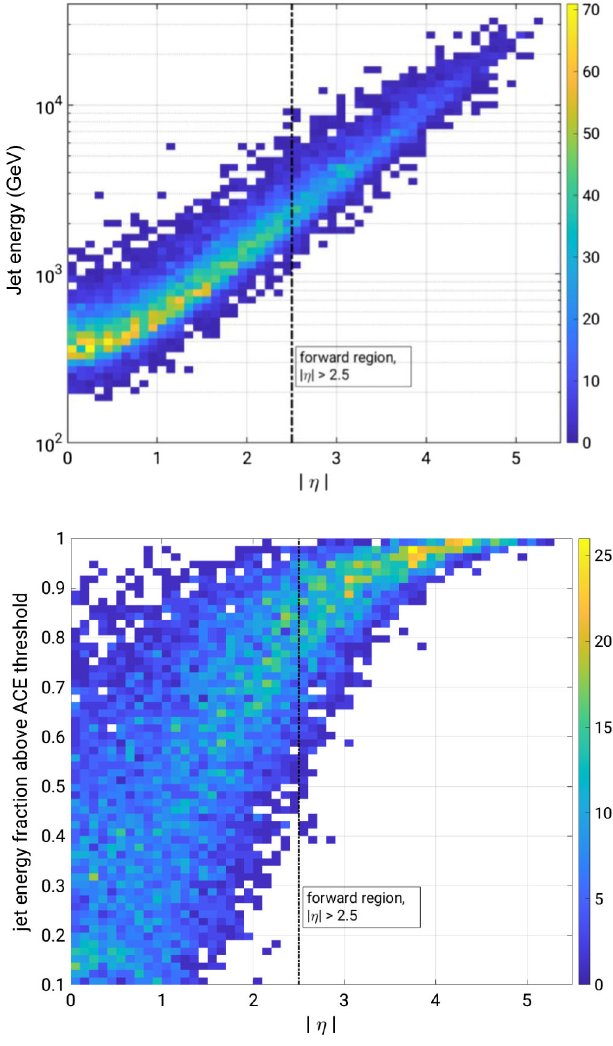
FIG. 33. Top: total jet energy vs pseudorapidity for 100 TeV PYTHIA 8 jets. The vertical line indicates the forward region where our study is focused. Bottom: fraction of jet component particles that are expected to be above the ACE timing threshold as a function of pseudorapidity, again with the vertical division indicated the forward region. In each case, the color bars indicate the number of jets per bin in the